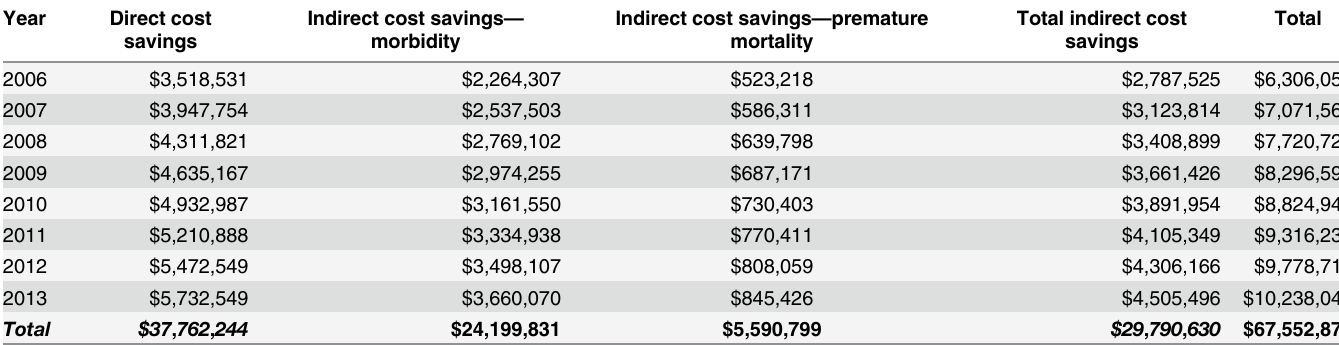
Table 3. Economic value of averting skin cancer cases and deaths, 2006 – 2013.